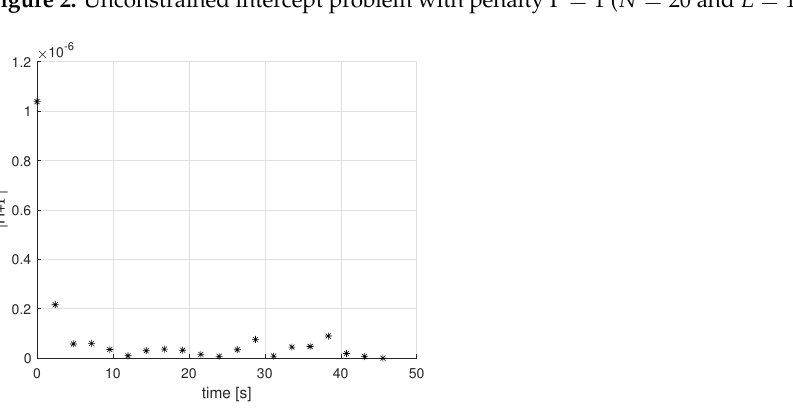
Figure 3. Hamiltonian loss for the unconstrained intercept problem with penalty Γ = 1 ( N = 20 and L =